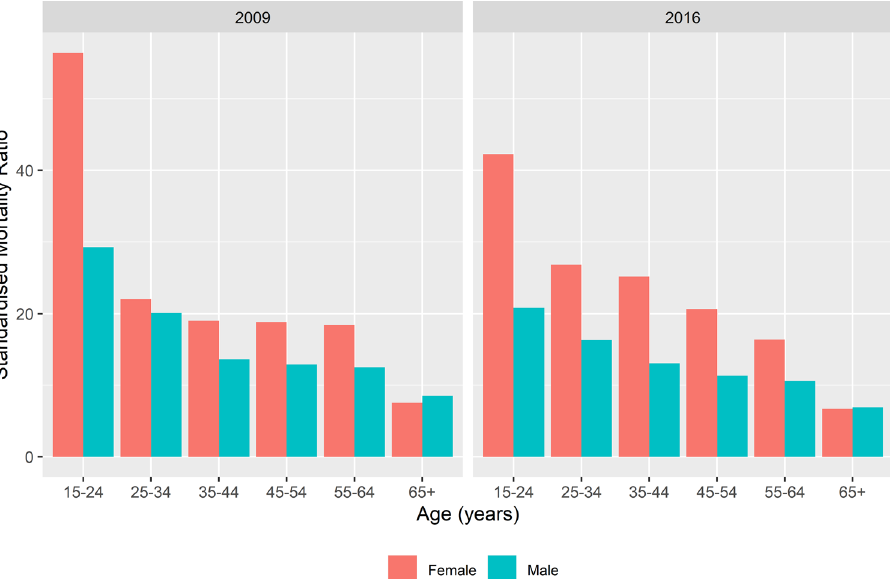
Figure 3. Standardised mortality ratio of adults (≥ 15 years) on drug-susceptible tuberculosis treatment by age category and sex for 2009 and 2016, South Africa.